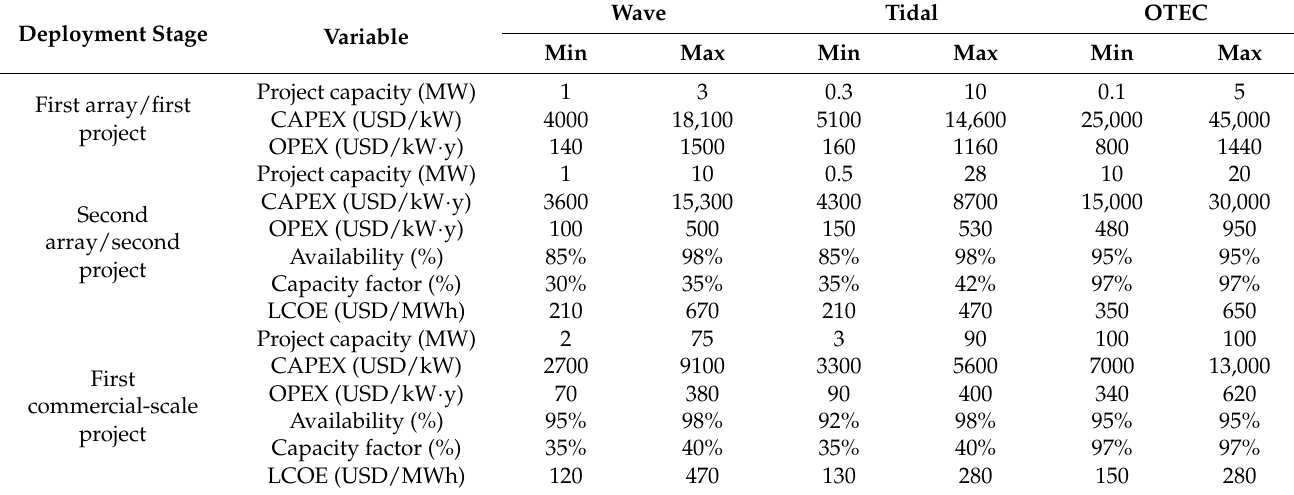
Table 10. Summary data averaged for each deployment and technology type, based on the Interna- tional Levelized Cost of Energy for the Ocean Energy Technologies report by the International Energy Agency-Ocean Energy Systems (IEA-OES) [211].